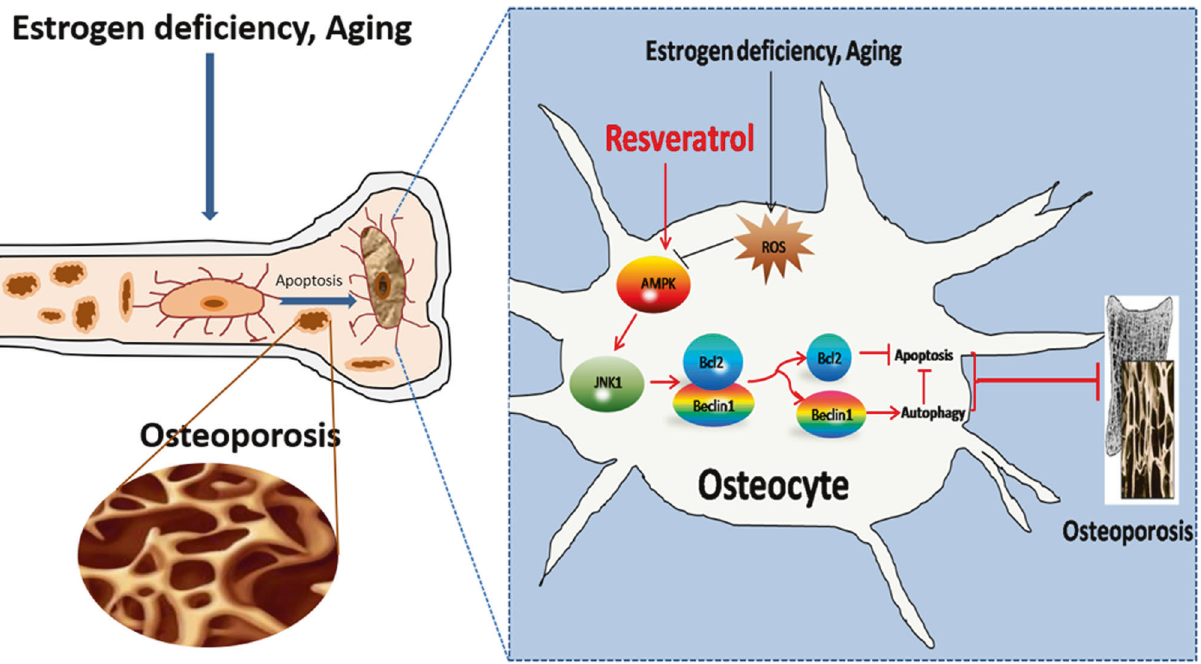
Fig. 8 Schematic diagram for the molecular regulation of resveratrol against ovariectomized osteoporosis with osteocytes as target. Resveratrol protects osteocytes by regulating the switch between autophagy and apoptotic machinery under estrogen de fi ciency conditions, which is attributed by AMPK/JNK-mediated dissociation of Beclin-1-Bcl-2. ROS reactive oxygen species, AMPK Adenosine 5 ‘ -monophosphate (AMP)-activated protein kinase, JNK1 c-Jun N-terminal